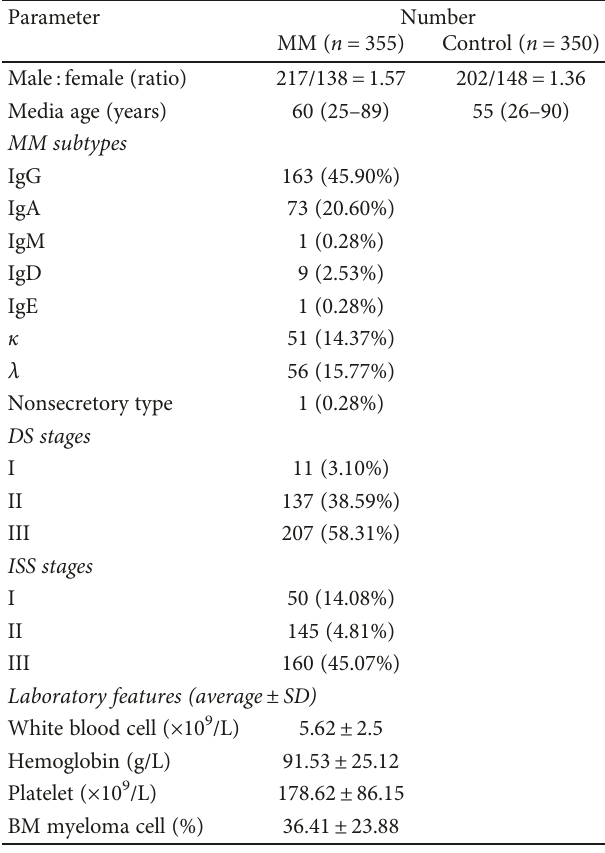
Table 1: Samples